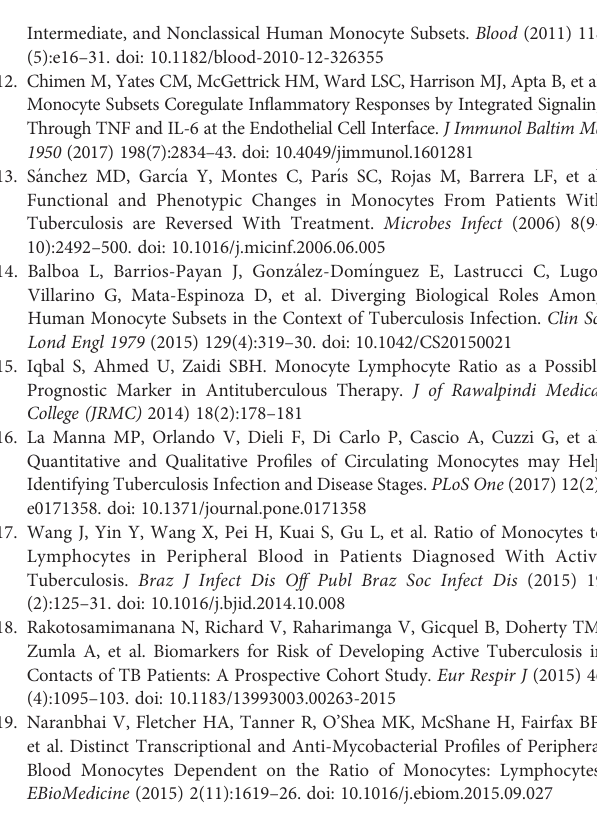
Supplementary Figure 1 | Individual expression of monocyte (CD14. CD16, HLADR, CD64 and CD86) markers on UMAP between the study populations. Supplementary Figure 2 | Individual expression of DC (CD11c, CD123, CD141 and HLADR) markers on UMAP between the study